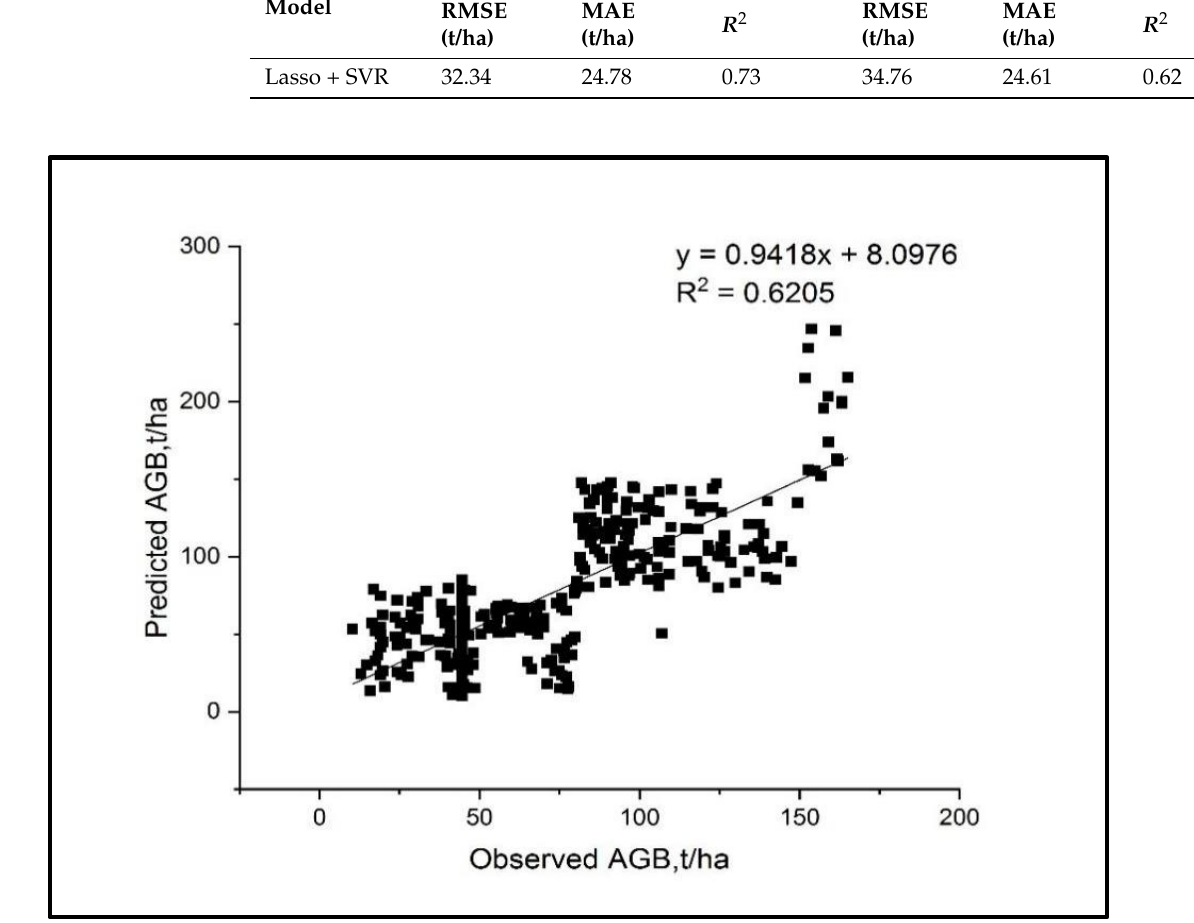
Figure 7. Validation results based on the Lasso-SVR model accuracy.